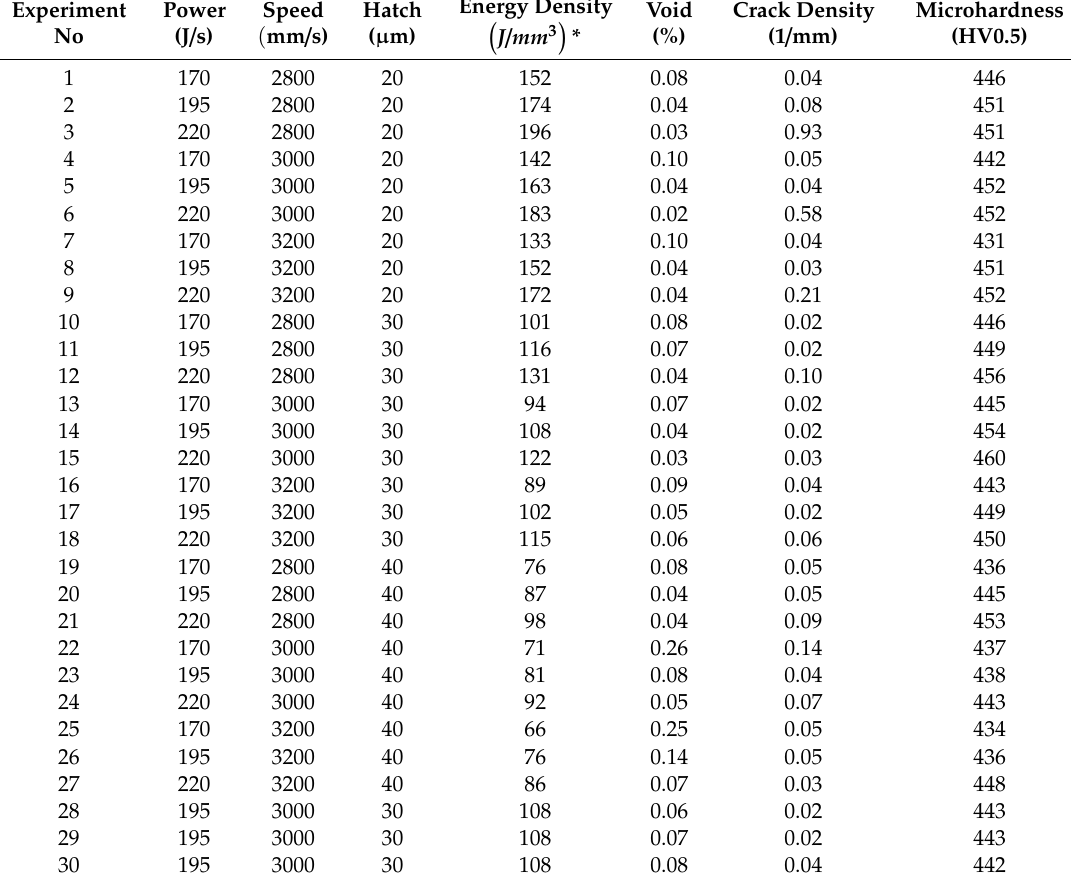
Table 1. Full factorial design and measured